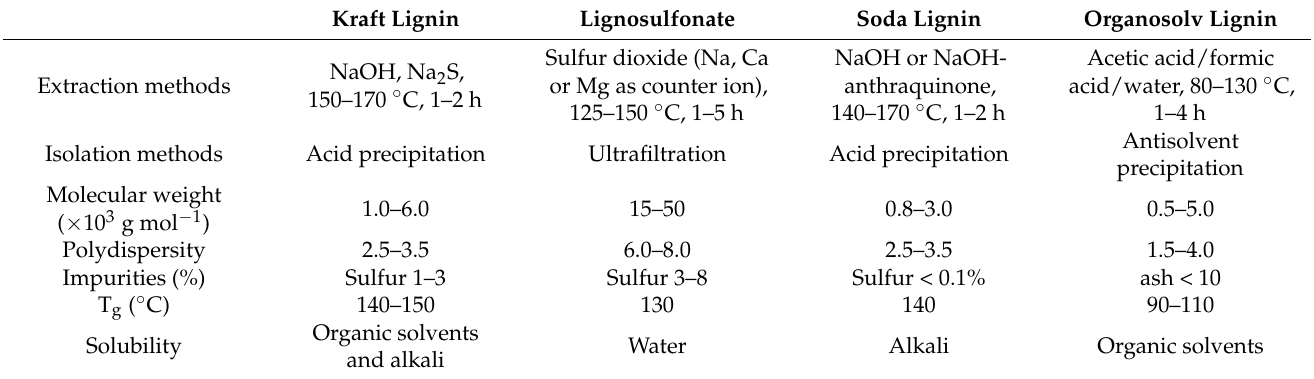
Table 1. Physicochemical properties of lignin produced in pulping process (From Refs.